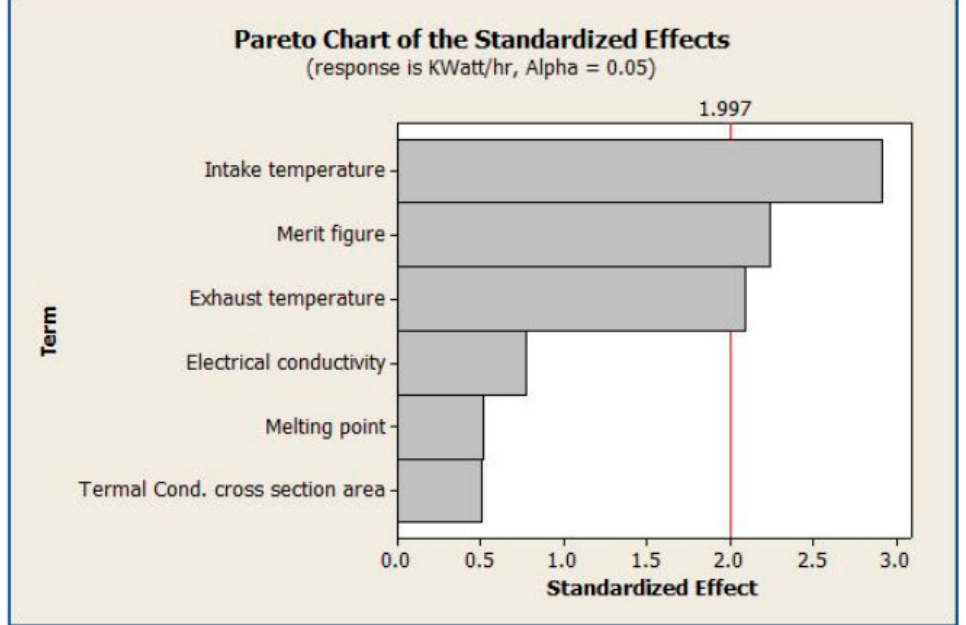
Figure 9. The significant parameters affected by power generation.